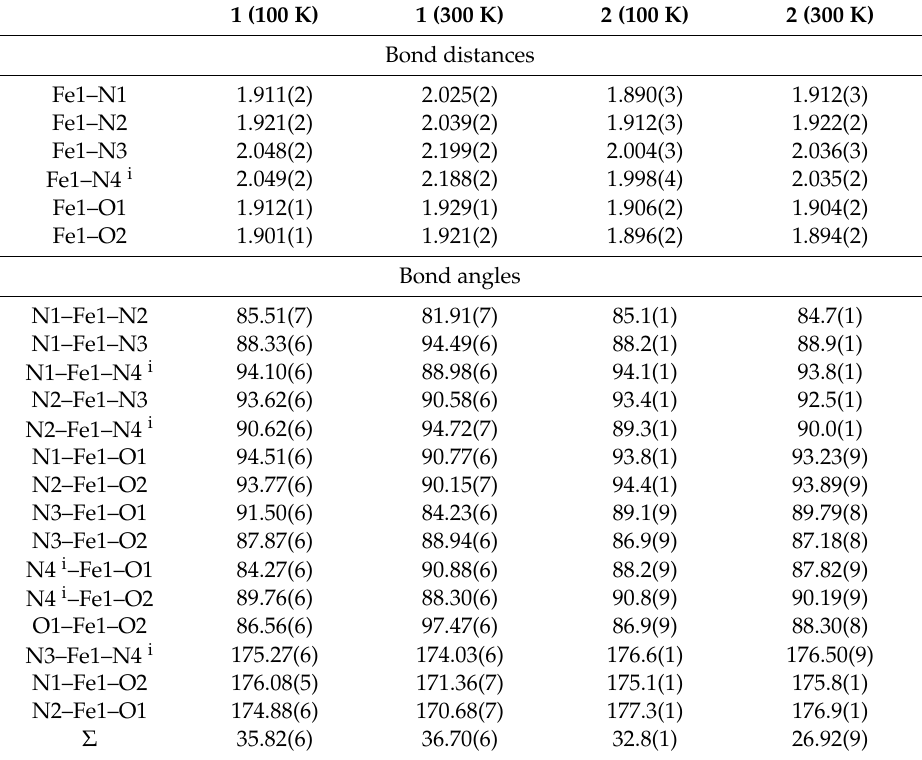
Table 1. Selected bond distances (Å) and angles ( ◦ ) 1 for 1 and 2 at 100 and 300 K.